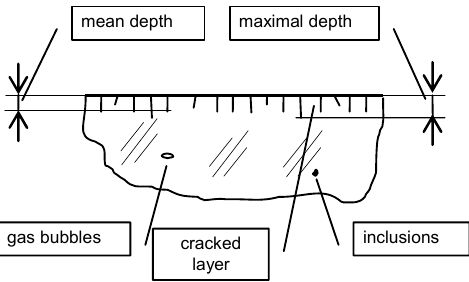
Figure 1: The micro-cracks in the surface cracked layer and internal defects in